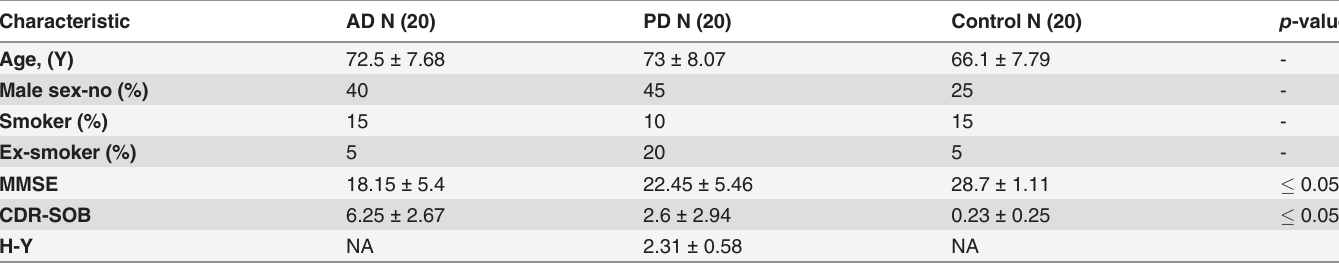
Table 1. Demographic and clinical data of the study participants.